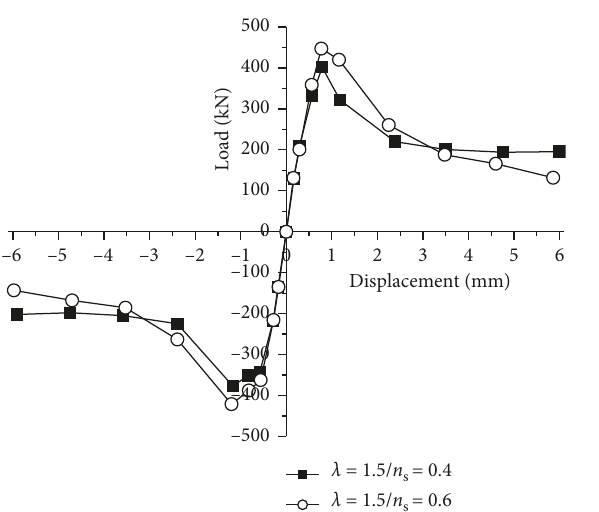
Figure 22: Skeleton curves of the RC columns under different axial compression ratios.